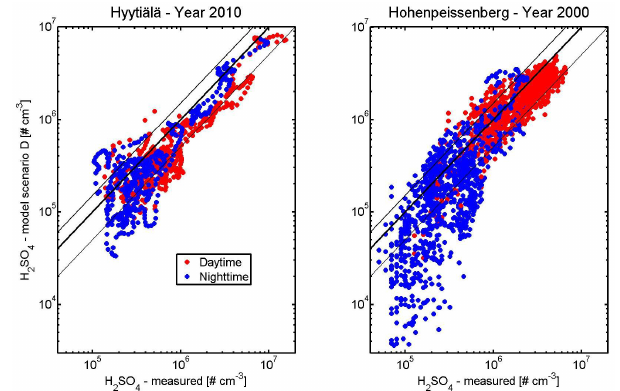
Fig. 7. Scatter plot of measured against modelled sulfuric acid con- centrations for the selected periods at both stations based on sim- ulation with scenario D (for the definition of the scenarios, see Sect. 3.3); black thick lines indicate the 1 : 1 range and black thin lines the 50% uncertainty interval.